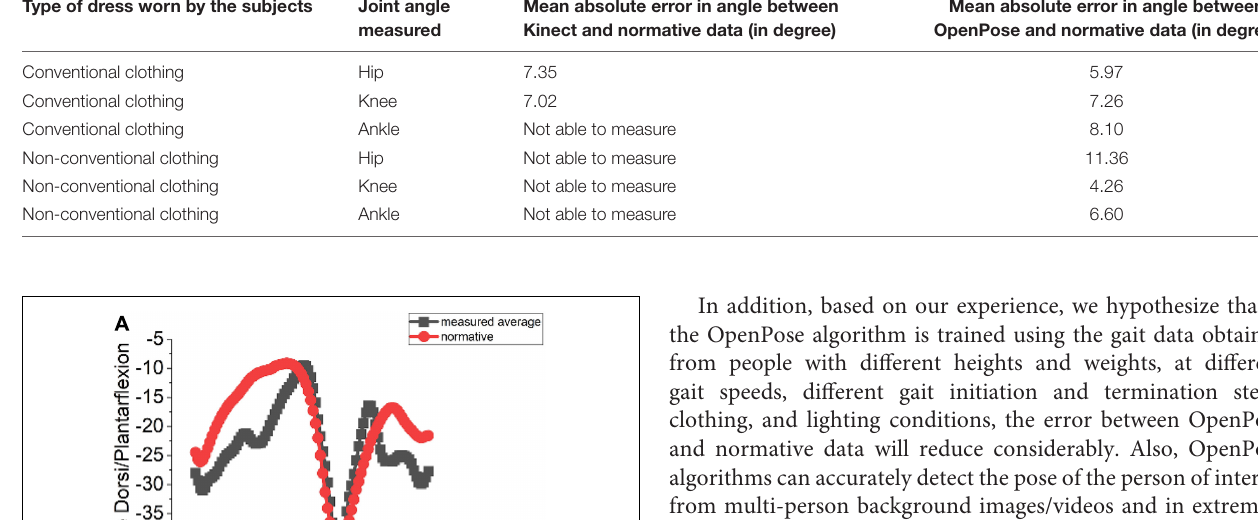
TABLE 3 | Comparison between Kinect and the proposed system for different dress attire with normative database. Type of dress worn by the subjects Joint angle measured